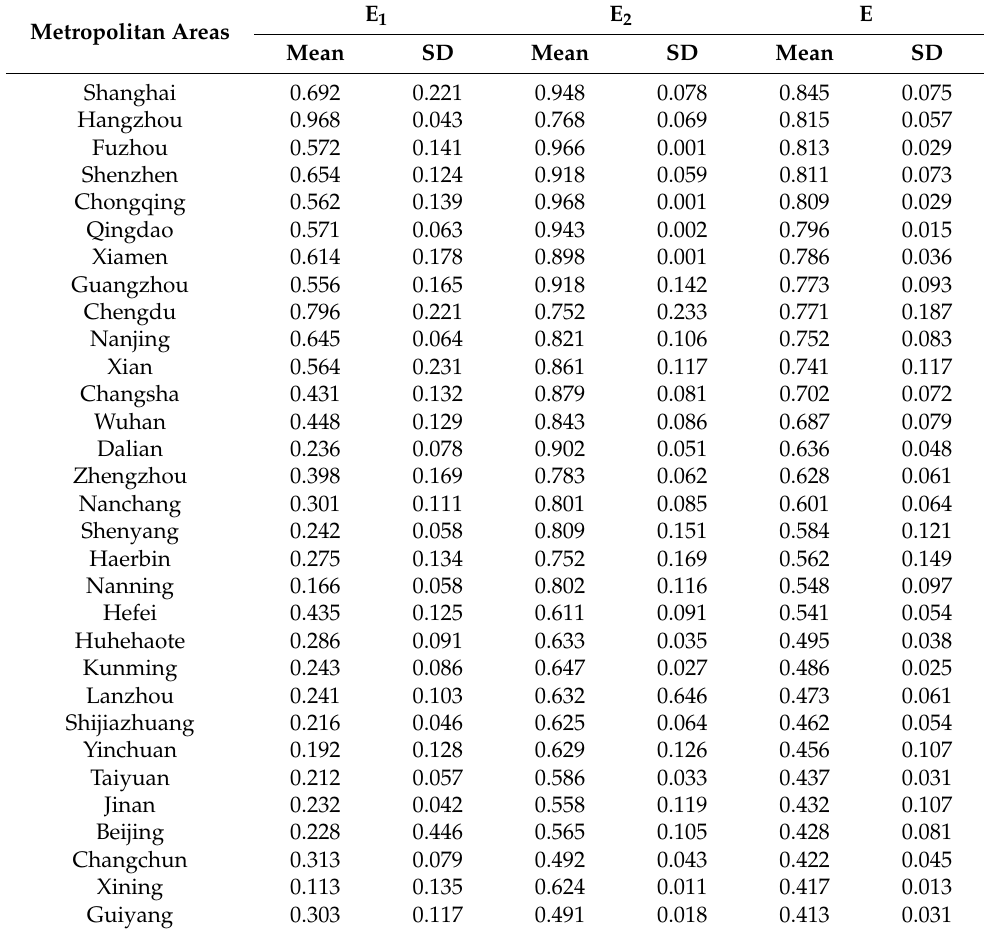
Table 2. Measurement results of innovation resource allocation efficiency. Metropolitan